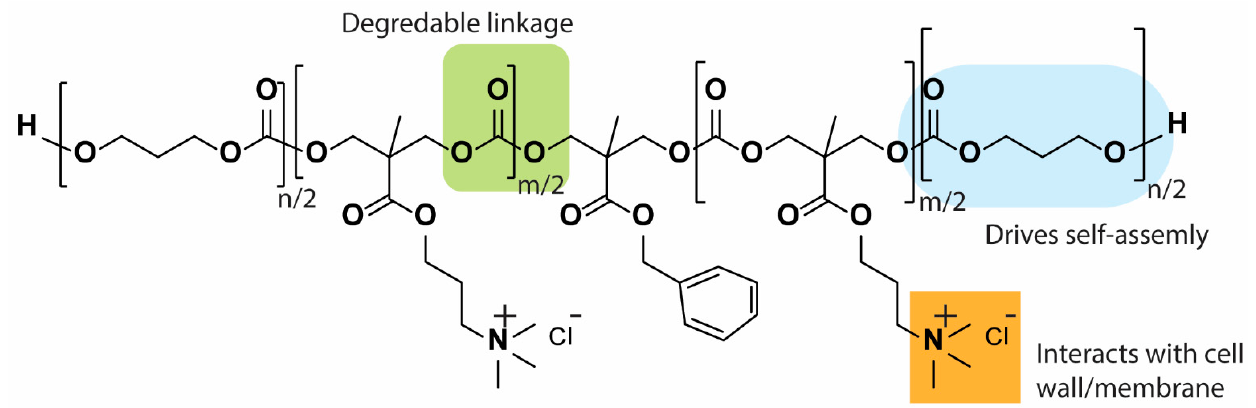
Figure 8. An example of biodegradable cationic amphiphilic polycarbonates-based polymer [133] .